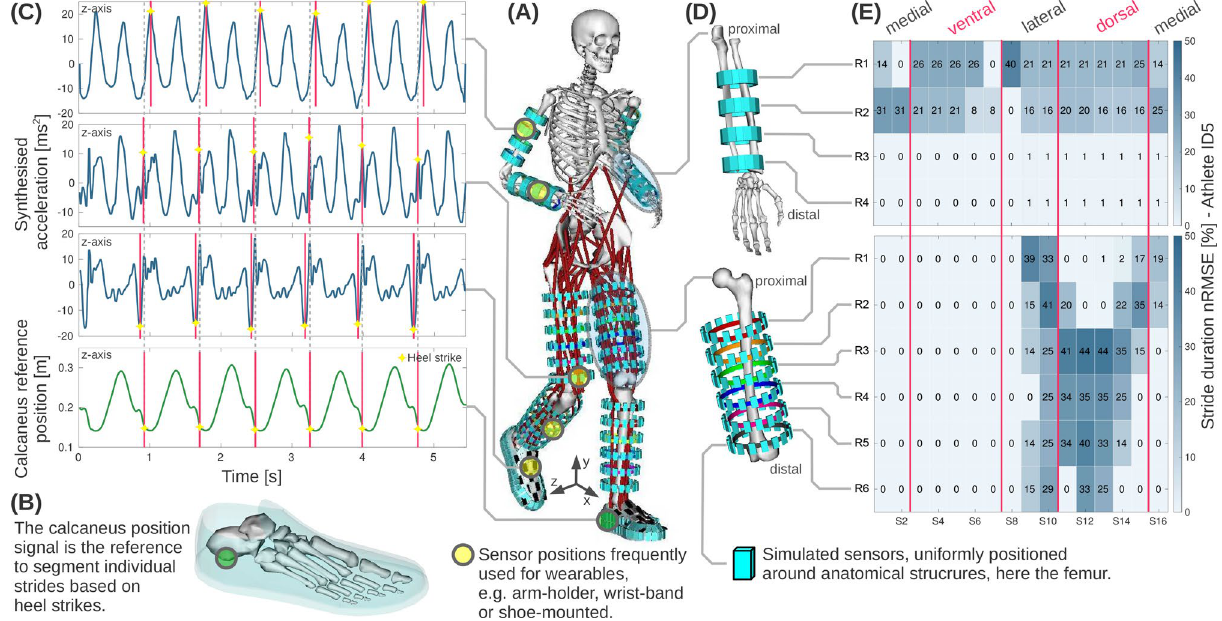
Figure 2. Illustration of the wearable motion analysis based on biomechanical simulations and sensor data synthesis. ( A ) Illustration of the sensor-extended, personal full-body model while running, including 834 simulated sensors uniformly positioned at upper and lower arms and legs, as well as feet. ( B ) Feet models with an inertia-free shoe model used to place sensor models. The vertical calcaneus position in y-axis orientation served as stride reference. ( C ) Example of the acceleration time series data synthesised for each simulated sensor. ( D ) Zoomed view of the lower arm (64 sensors), and the upper leg (96 sensors). For visualisation of the sensor positions, the femur was rotated. ( E ) Normalised root-mean-square-error (nRMSE) of the marker stride duration, derived between simulated sensors and the calcaneus reference. Colour-coded nRMSE maps shown here for athlete ID5.